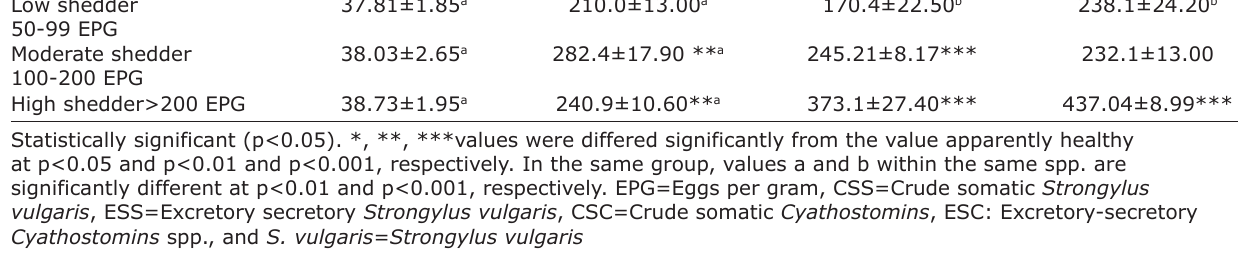
Table-4: Diagnostic accuracy values using different prepared S. vulgaris and Cyathostomins spp. antigens by ELISA.